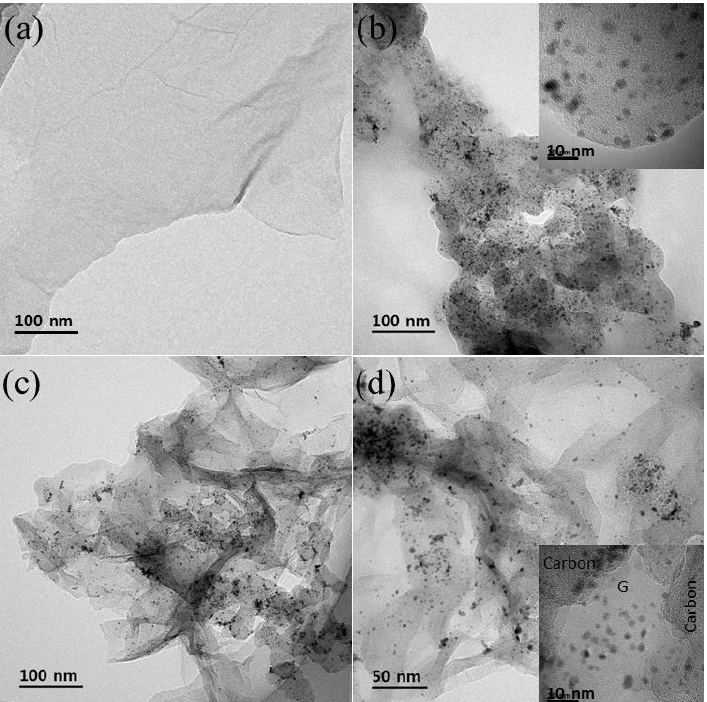
Figure 1. TEM images of G-sheets ( a ), Pt / C ( b ) and Pt / C 8 :G 2 ( c , d ); insets: high resolution TEM (HRTEM) of Pt / C ( b ) and Pt / C 8 :G 2 ( d ).